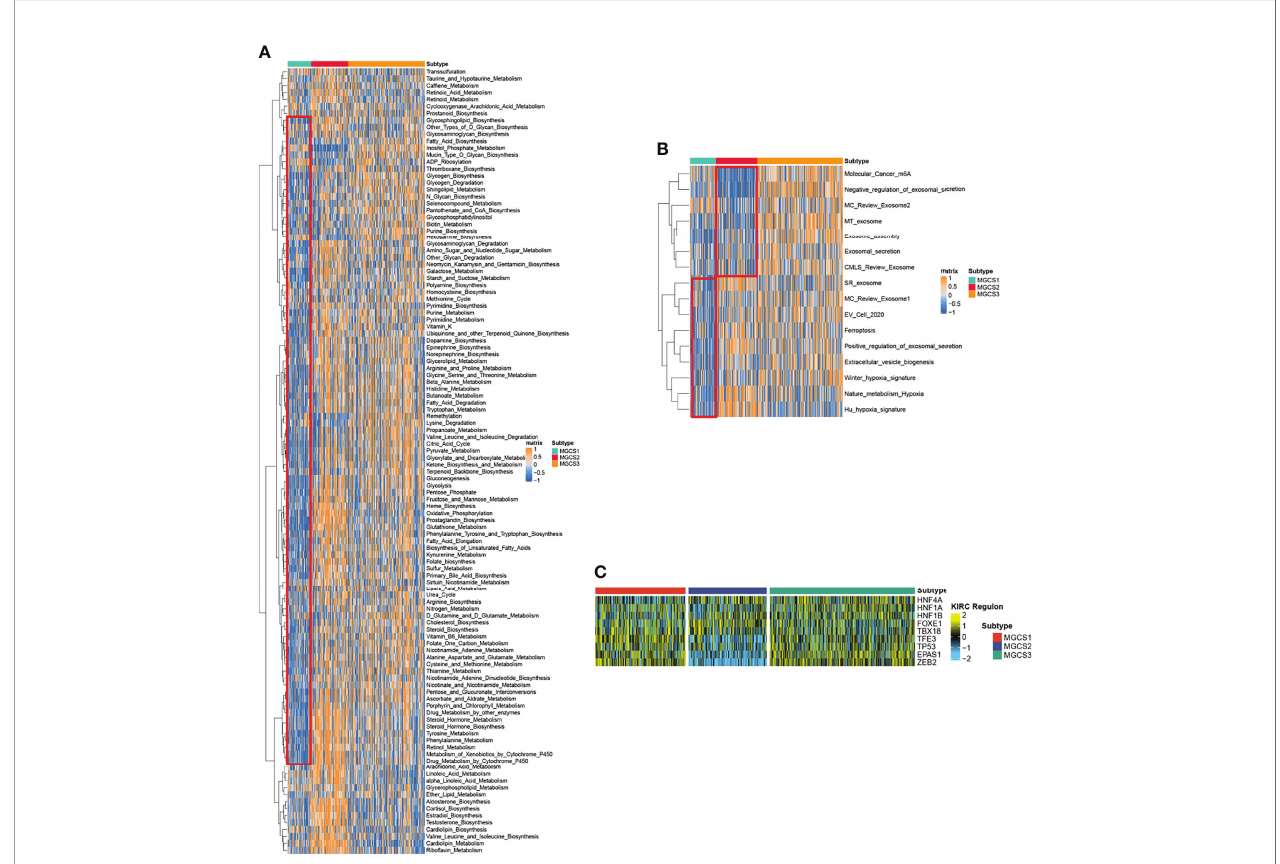
FIGURE 3 | Functional enrichment analysis of MGCS1, MGCS2 and MGCS3 subgroups. (A, B) Heatmap of metabolism-related and cancer-related pathway enrichment scores among the subtypes by GSVA analysis. Orange represented activated pathways and blue represented inhibited pathways. (C) Heatmap of transcription factor regulon activation in three m 7 G modi fi cation subtypes. Yellow represented transcription factor regulation-activation. Blue represented transcription factor